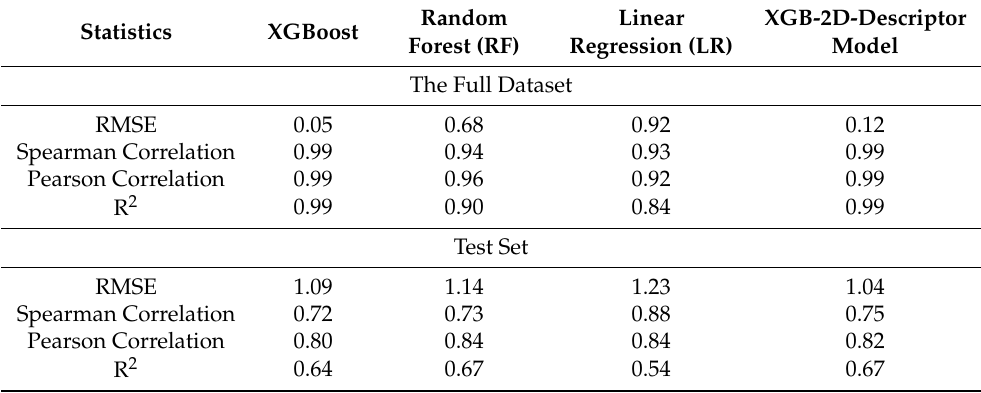
Table 4. Performance metrices of the machine learning model in the quantitative predictions of logK DED/W